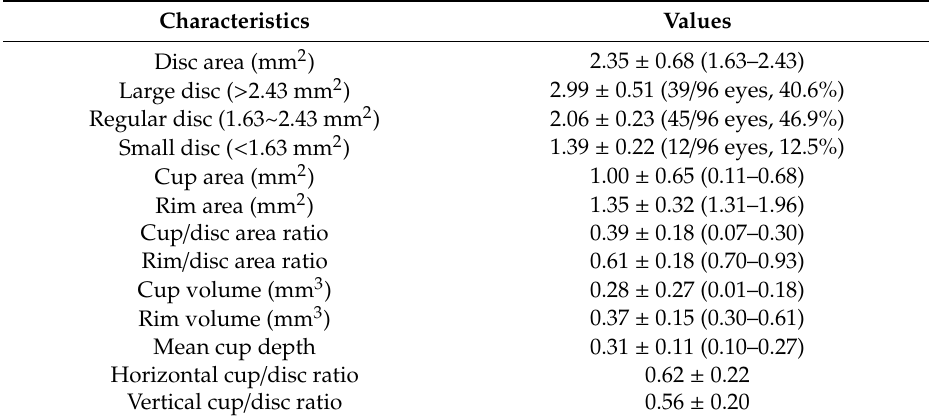
Table 2. Optic disc parameters of the